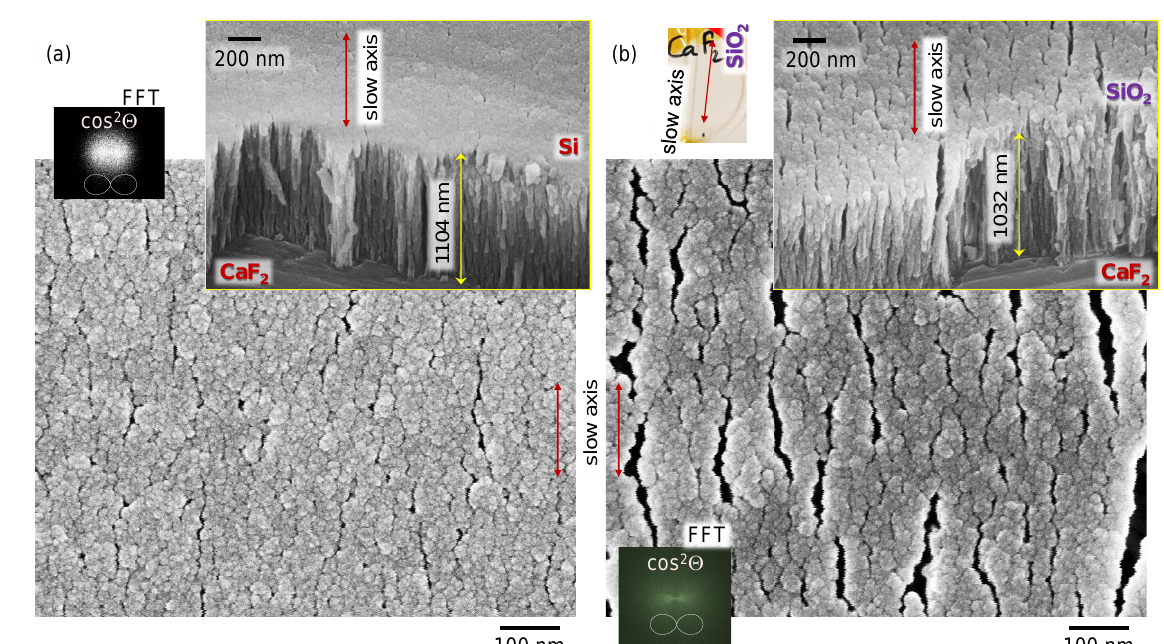
Figure 5. SEM images of a ∼ 1 µ m thick columnar Si ( a ) and SiO 2 ( b ) on CaF 2 substrate. A coating of 20 nm thick Cr was used for SEM imaging (columnar Si film without Cr coating is shown in Figure 3). Top-insets were taken at π /4 tilt and film √ thickness was calculated with a factor of sin ( π /4 ) as H = y / 2; where y is the vertical length on the